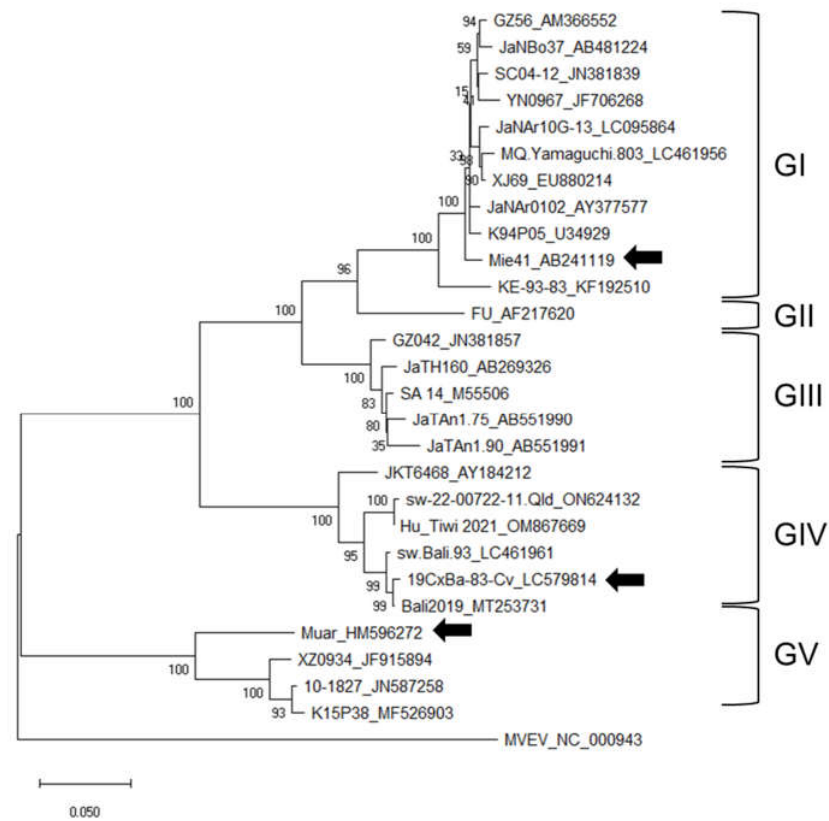
Figure 1. Phylogenetic tree of JEV based on the complete nucleotide sequences of the E gene. Numbers at branch points indicate bootstrap values (500 replicates). Genotypes (GI, GII, GIII, GIV, and GV) are shown. Arrowheads indicate the three strains (GI Mie/41/2002, GIV 19CxBa-83-Cv, and GV Muar) that were characterized further in this